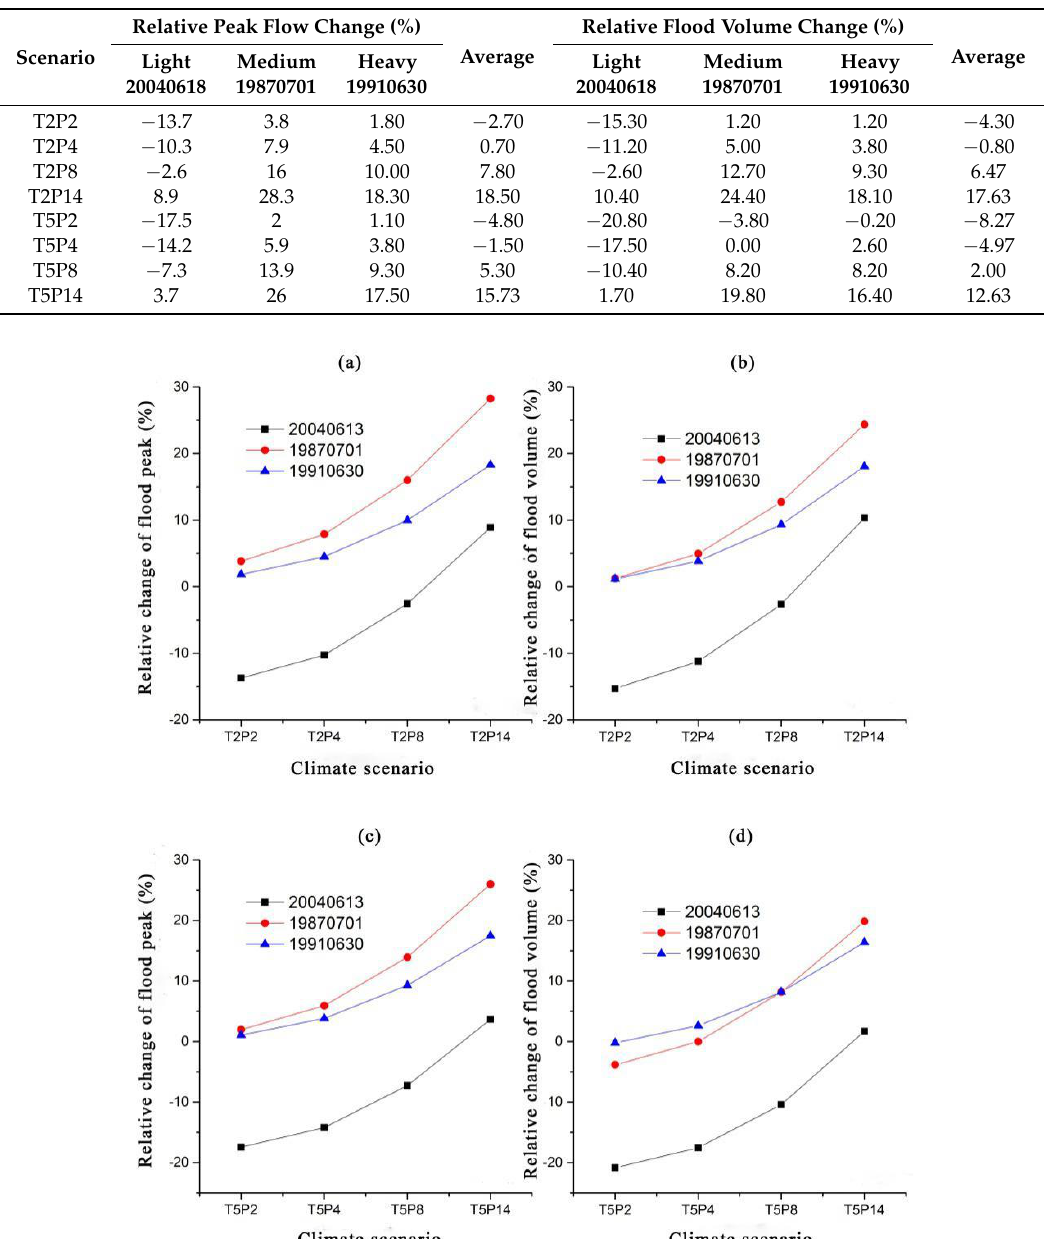
Figure 3. The hydrological response of increased temperature and precipitation for different-scaled floods: ( a ) Relative change of flood peak under increased temperature and precipitation scenario (temperature rises 2 °C); ( b ) Relative change of flood volume under increased temperature and precipitation scenario (temperature rises 2 °C); ( c ) Relative change of flood peak under increased temperature and precipitation scenario (temperature rises 5 °C); ( d ) Relative change of flood volume under increased temperature and precipitation scenario (temperature rises 5 °C).